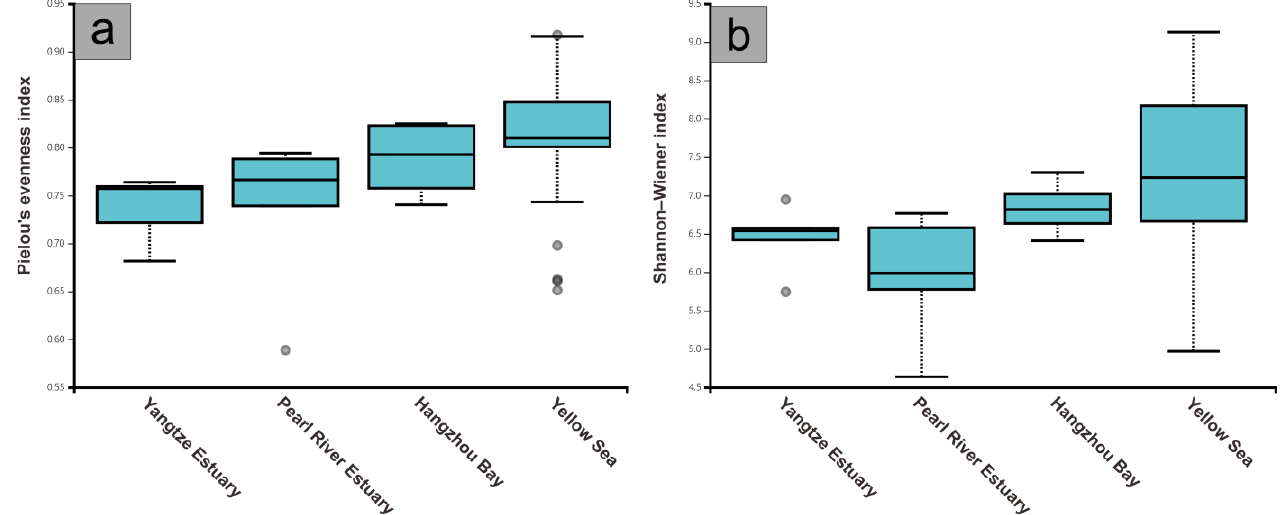
Figure 7. Boxplot of Pielou’s evenness index ( a ) and Shannon – Wiener index ( b ).